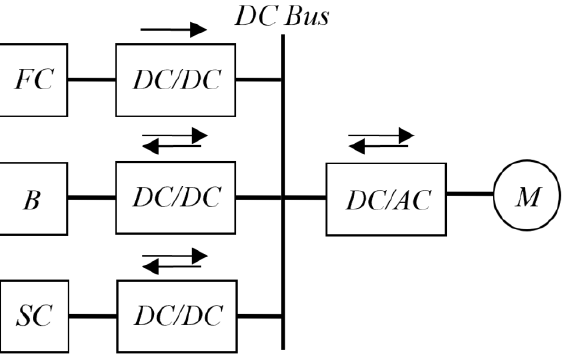
Figure 8. Combined vehicle system with FC as the main energy source and controllable auxiliary sources B and SC .